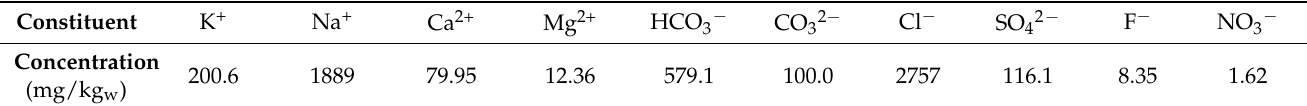
Table 6. Concentration of each constituent in the geothermal